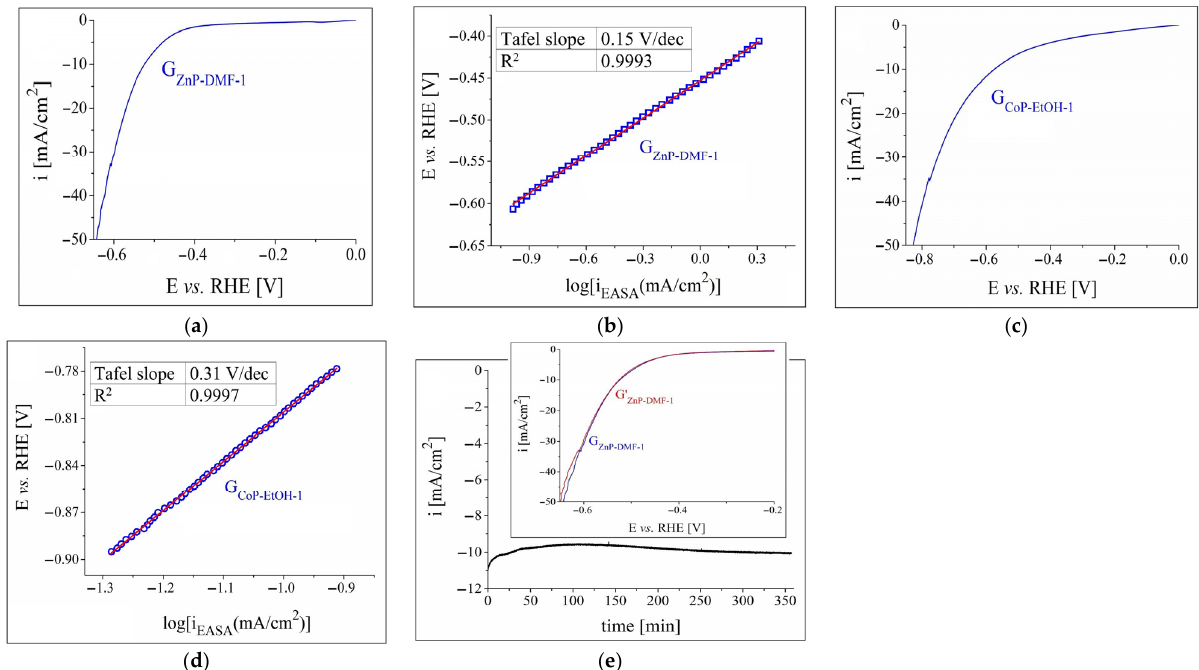
Figure 7. ( a ) Cathodic polarisation curve recorded in 1 M KOH electrolyte solution on the G ZnP-DMF-1 electrode at v = 5 mV/s. ( b ) The Tafel plot for the G ZnP-DMF-1 sample in 1 M KOH solution. ( c ) Cathodic polarisation curve obtained in 0.5 M H 2 SO 4 electrolyte solution on the G CoP-EtOH-1 electrode. ( d ) The Tafel plot for the G CoP-EtOH-1 sample in 0.5 M H 2 SO 4 solution. ( e ) The i–time curve recorded on the G ZnP-DMF-1 electrode in 1 M NaOH solution and inset with the LSVs traced on the same specimen, before (G ZnP-DMF-1 ) and after (G (cid:48) ZnP-DMF-1 ) the stability test. Table 3. The η H2 and Tafel slope values for the G ZnP-DMF-1 and G CoP-EtOH-1 electrodes. Electrode Label Electrode